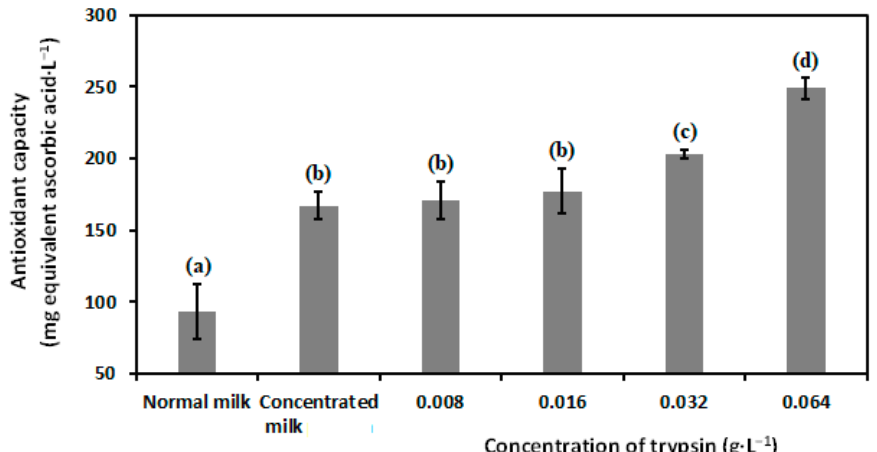
Figure 7. Antioxidant capacity of ultra-heat-treated skimmed milk, milk with concentrated proteins, and milk with concentrated proteins after enzyme treatment. Results are represented by mean value with standard deviation (± values). In superscript, dissimilar alphabet represents the significant difference between results, evaluated by the Tukey’s post hoc method.